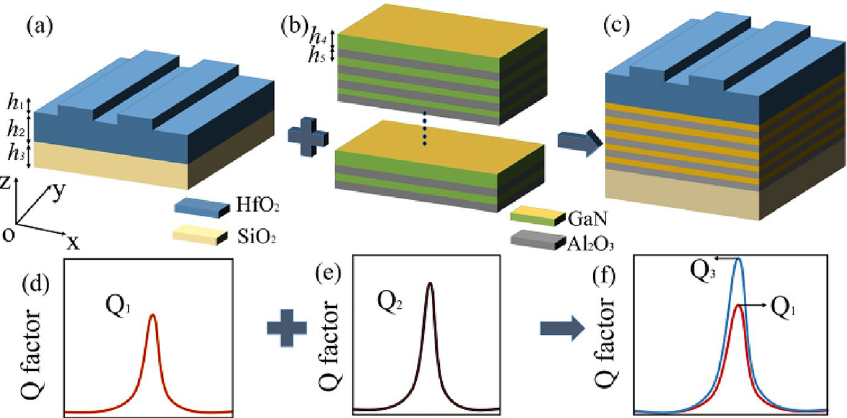
Figure 1. ( a – c ) Three-dimensional models of grating, multilayers, and mixed structures. ( d , e ) The Q value corresponding to the grating and multilayers with Q 1 being increased to Q 3 via the addition of the multilayer